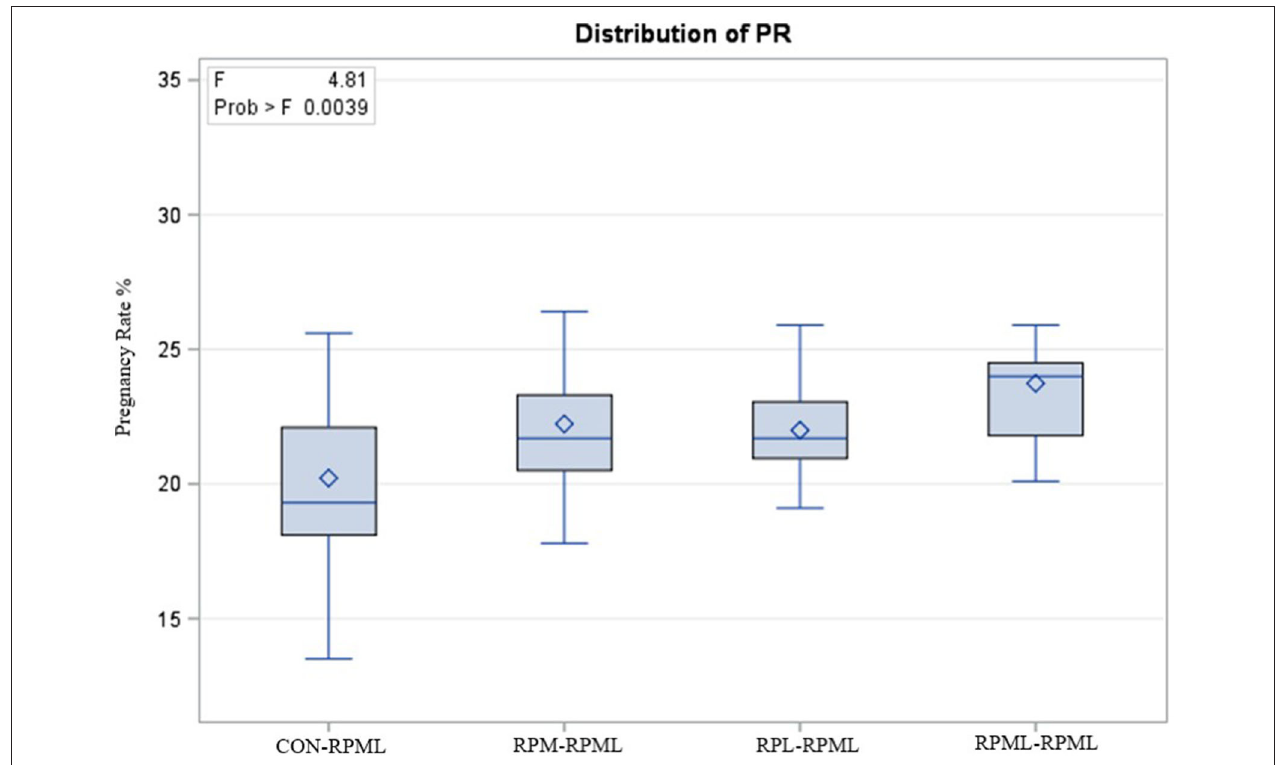
FIGURE 13 | Effect of supply ruminally protected Met and Lys to transition and milking dairy cows on pregnancy rate. Values are means; standard errors are represented by vertical